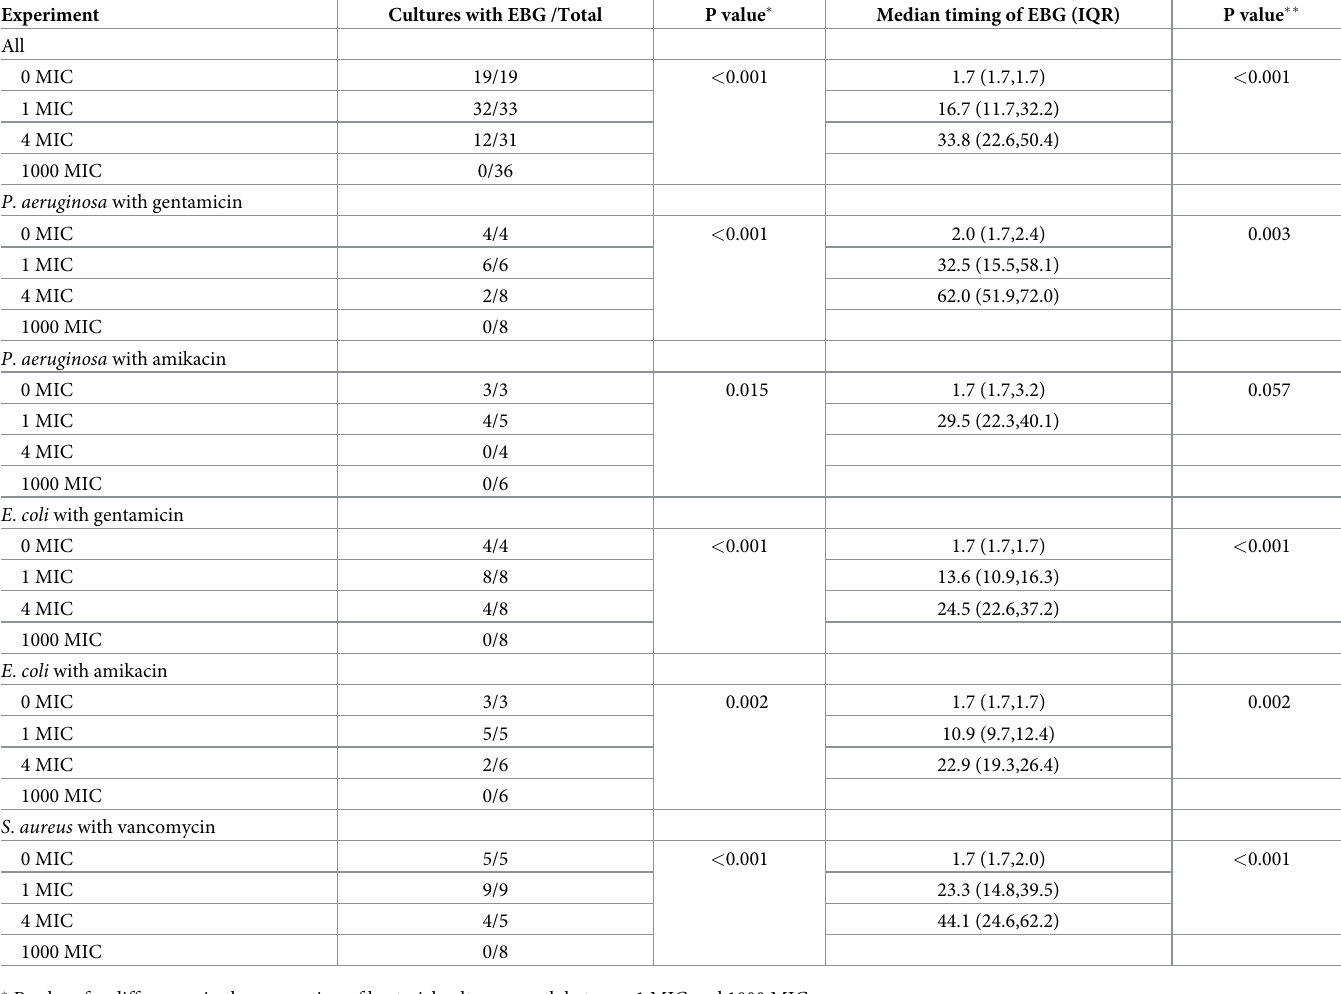
Table 1. Proportion and timing of cultures exhibiting exponential bacterial growth